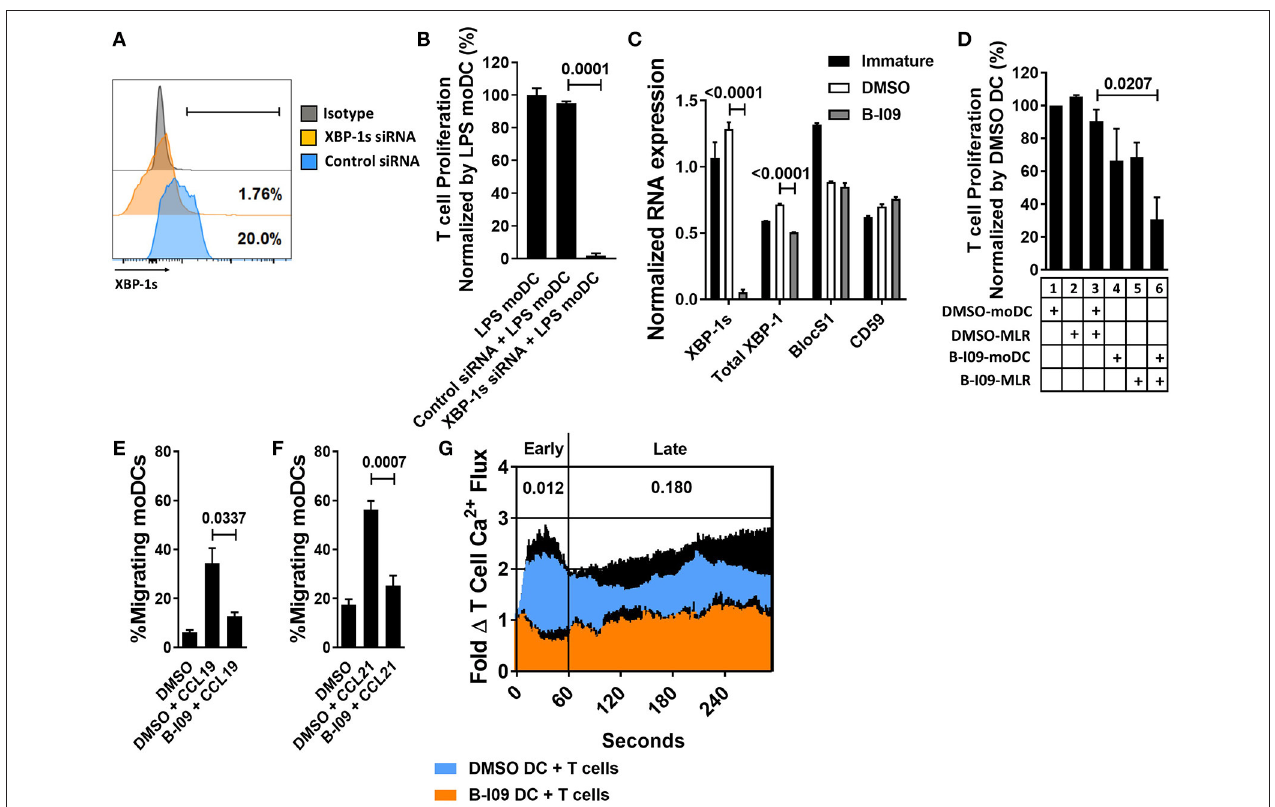
FIGURE 1 | XBP-1s inhibition reduces the stimulatory potency of moDCs toward allogeneic T cells . Human moDCs were stimulated with LPS (1 µ g/ml) for 24h in the presence of XBP-1 or control siRNA. (A) Representative histograms show XBP-1s expression in siRNA-treated moDCs. (B) T cells were stimulated by XBP-1- or control-siRNA-treated moDCs in alloMLRs. T cell proliferation (MTS colormetric assay) after 5 days is shown. AlloMLRs were plated in replicates of 5 at a moDC: T cell ratio of 1:30. 1 representative experiment of 2 independent studies is shown, Dunnett’s test. (C) Human moDCs were stimulated with LPS (1 µ g/ml) for 24h in the presence of B-I09 (20 µ M) or DMSO (0.1%). Bar graph shows triplicate mean XBP-1s or total XBP-1 mRNA, vs. the RIDD components BlocS1 and CD59 in B-I09- or DMSO-treated moDCs after 24h of LPS stimulation as measured by RT-PCR. 1 representative experiment of 4 independent studies is shown, Tukey’s test. (D) T